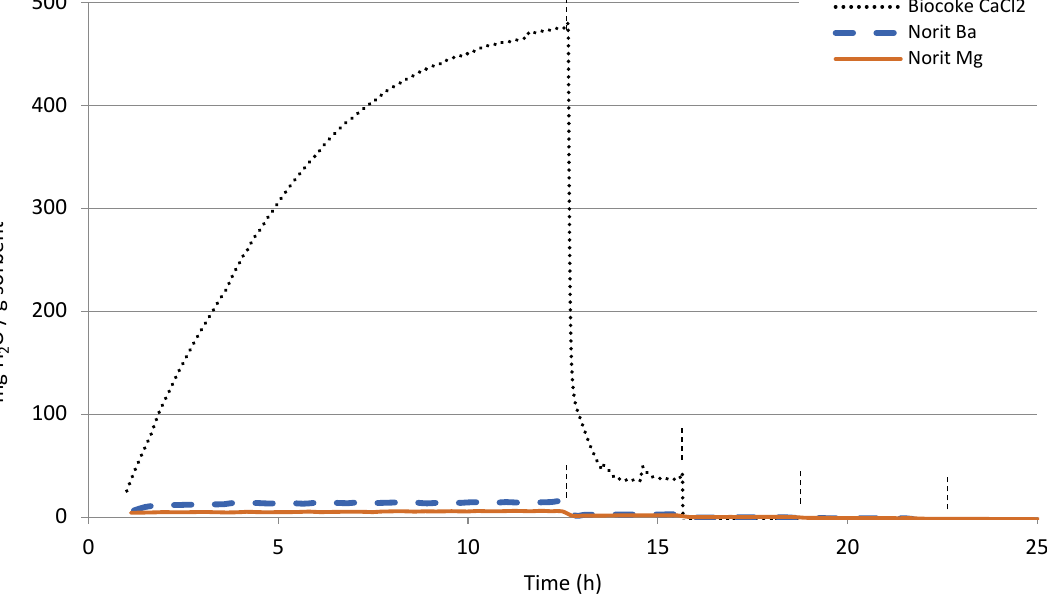
Figure 4. Water sorption capacity of the calcined and modified biocoke and commercial activated carbon Norit. The vertical lines in each graph indicate the temperature change: 25 °C, 100 °C, 200 °C, 300 °C and 400 °C.